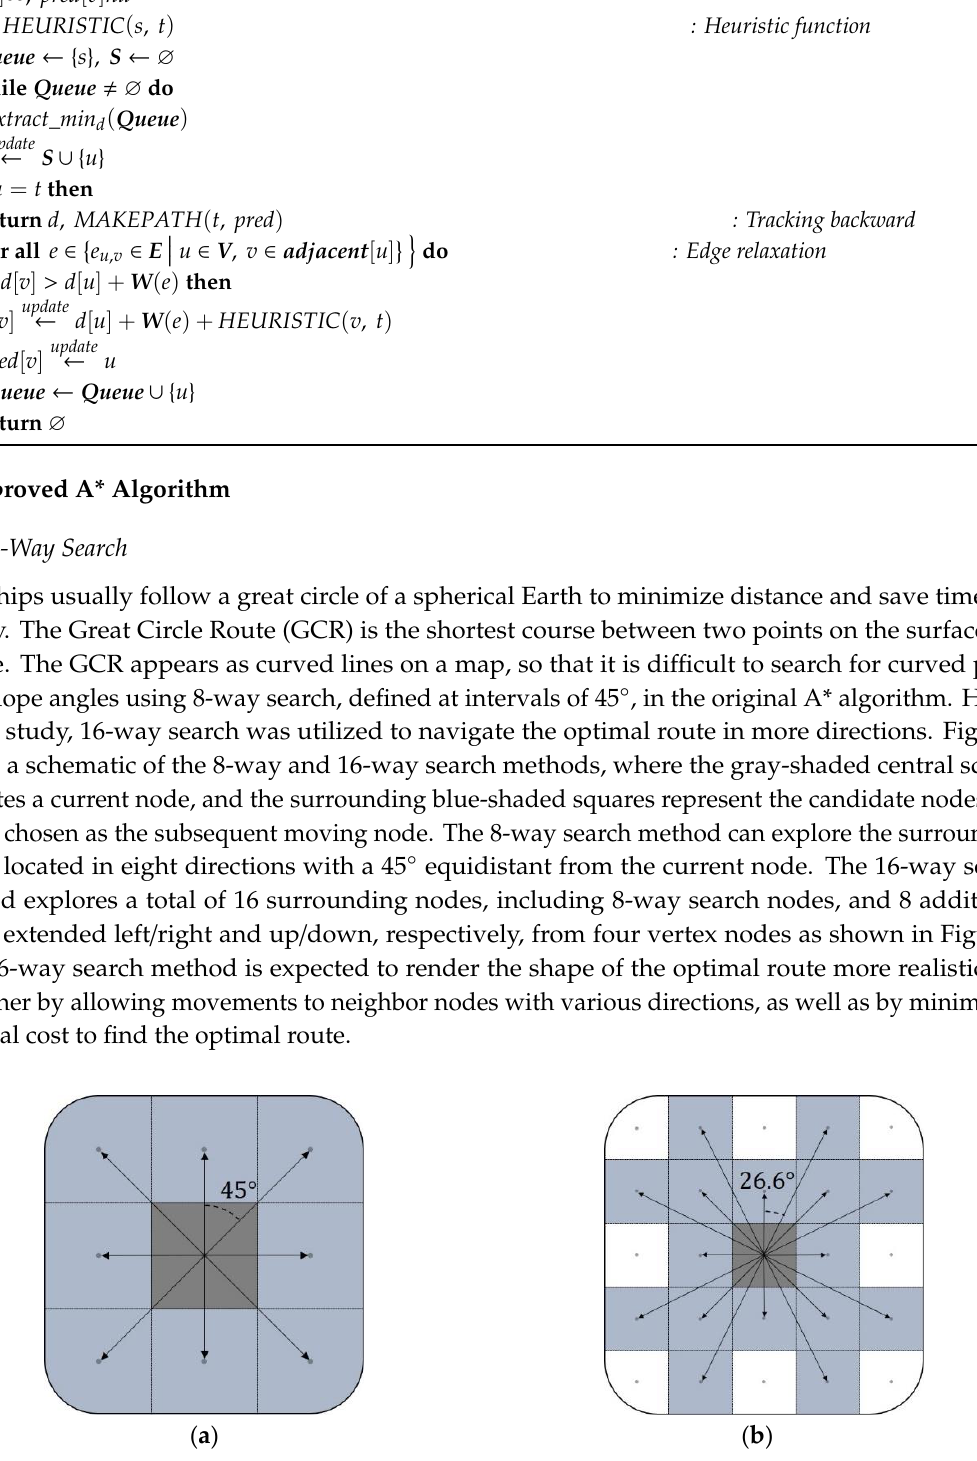
Figure 2. Configurations of ( a ) 8-way search method; ( b ) 16-way search method.